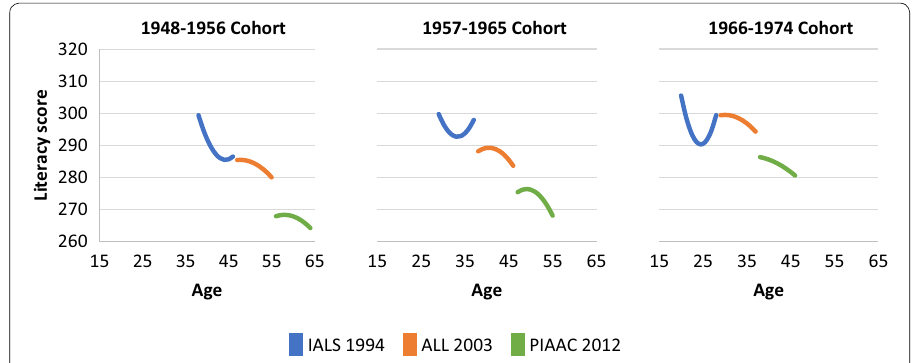
Fig. 2 Age-literacy relationship for three native-born cohorts, Canada, 1994 IALS, 2003 ALL and 2012 PIAAC. The predicted values of the literacy score are generated by regression models stratified by cohort and survey year. These models also include the following control variables: sex, province of residence, type of region (urban/rural), level of education, knowledge and use of official languages, mother’s level of education, practice of literacy activities at home, and use of writing skills at work (and labour market participation status)